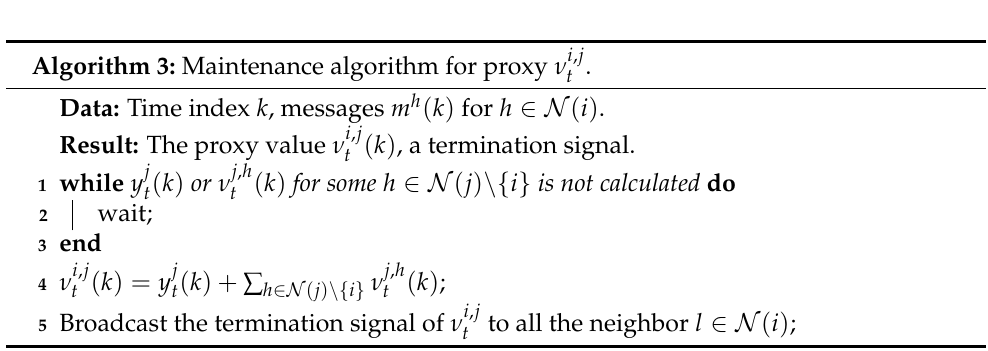
Algorithm 3: Maintenance algorithm for proxy ν i , j